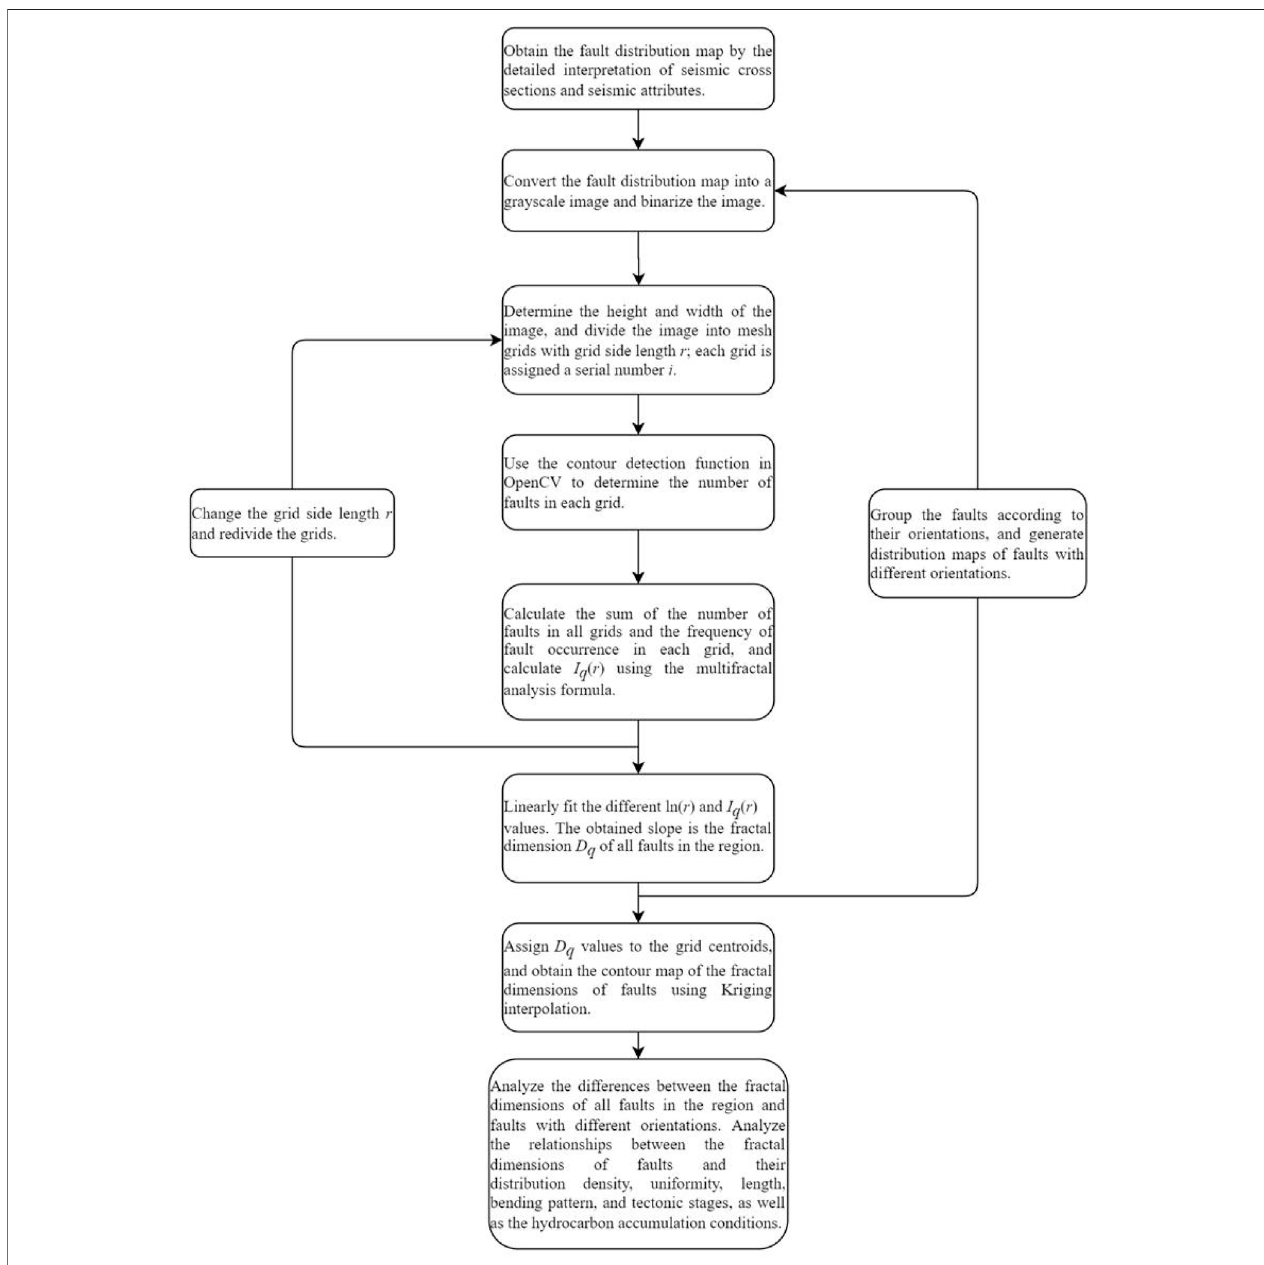
FIGURE 2 | Flow chart of image recognition – based multifractal calculation method for fault structures.